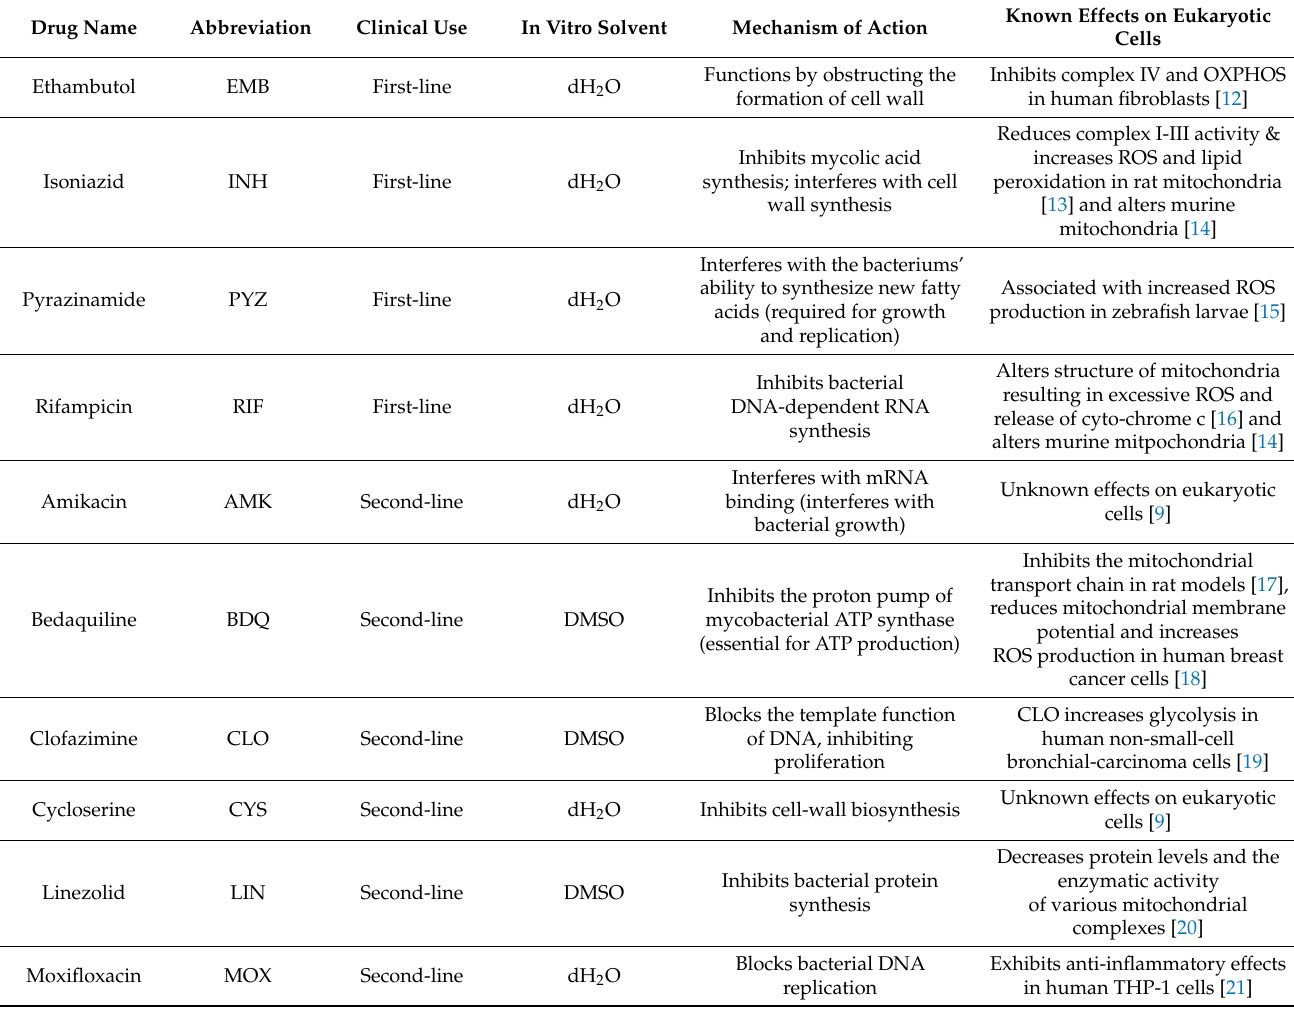
Table 1. Overview of TB drugs (mechanism of action and known effects on eukaryotic